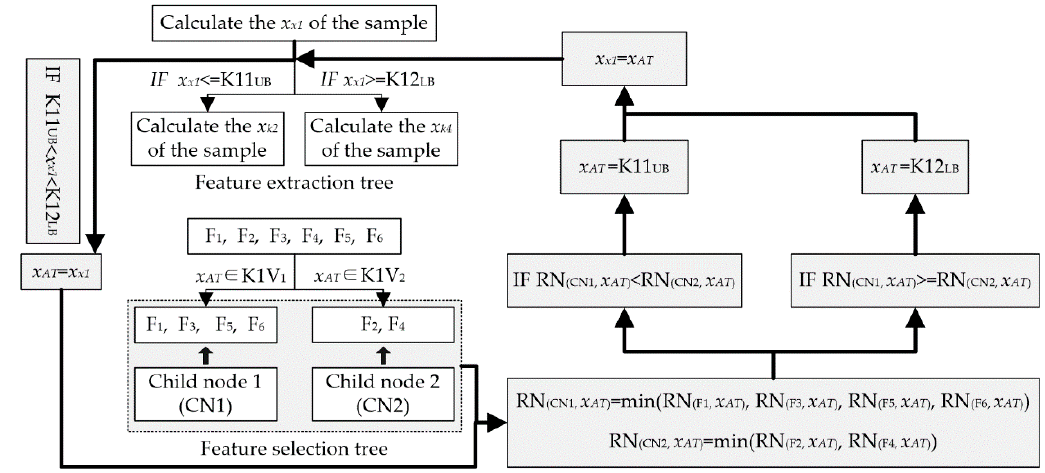
Figure 9. RS-DFV extraction based on the rough set.